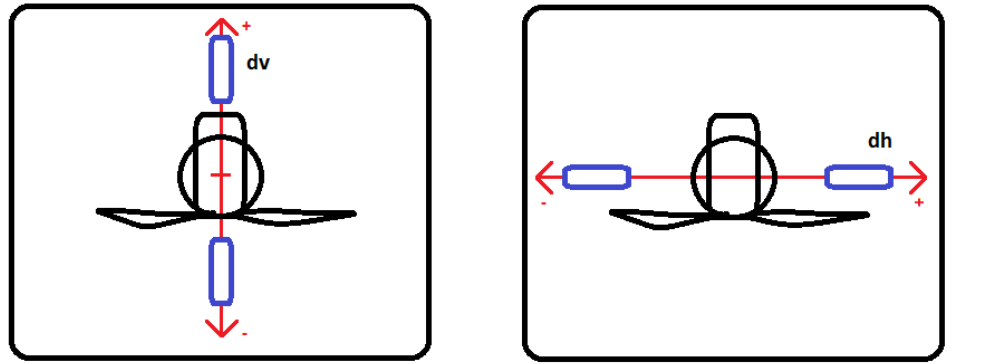
Figure 8. Displacement of both TMDs along the fore-aft ( left ) and side-side ( right ) axis keeping the